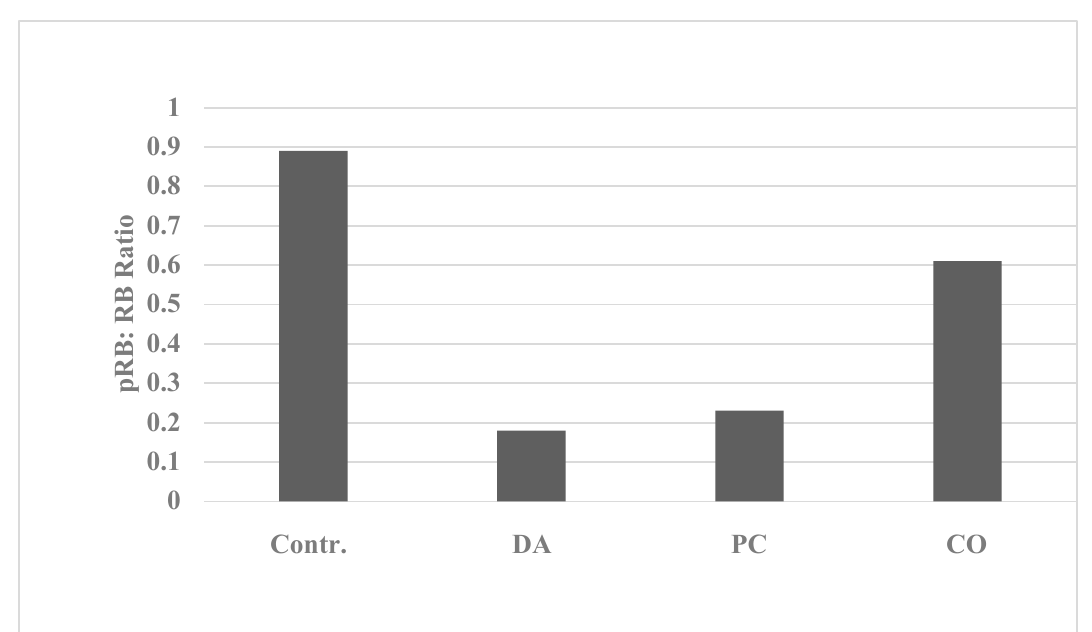
Figure 2. Effect of Chinese herbs on RB Signaling. Treatment with DA, PC and CO at their respective IC 90 doses decreased the pRB: RB ratio. Data presented as arithmetic means of ASU from duplicate determinations. pRB, phosphorylated RB; RB, retinoblastoma; ASU, arbitrary scanning unit; DA, Dipsacus asperoides ; PC, Psoralea corylifolia ; CO, Cornus officinalis . Data summarized from [14–16].